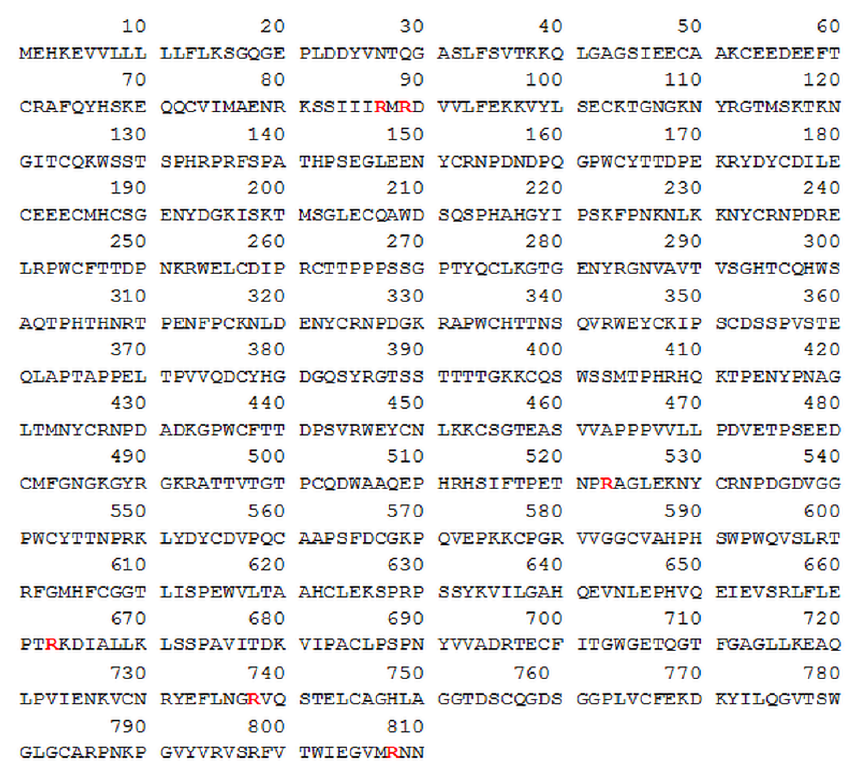
Figure 5. HPG sequence with arginine residues denoted in red text identified by LC-MS / MS as putatively modified by PPAD. The HPG sequence was obtained from UniProtKB database - P00747 (PLMN_HUMAN) record [41].